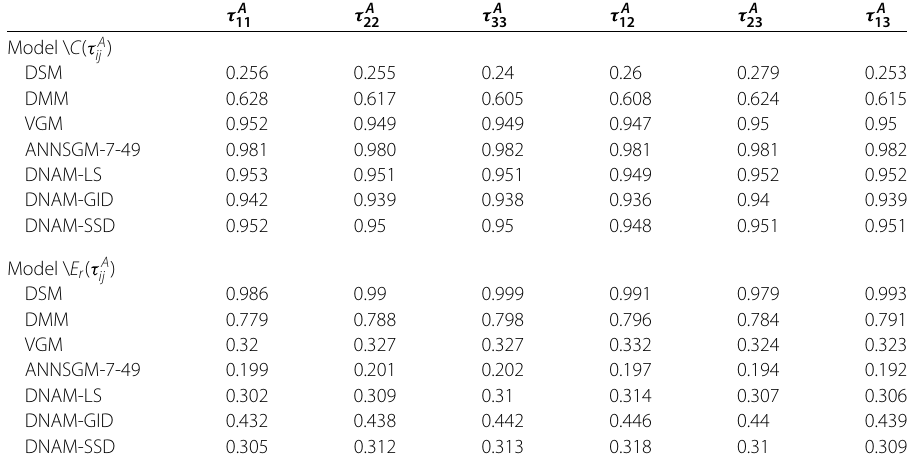
Table 3 Correlation coefficients and relative errors of the SGS stress at filter scale 16 h DNS in the a priori study A 11